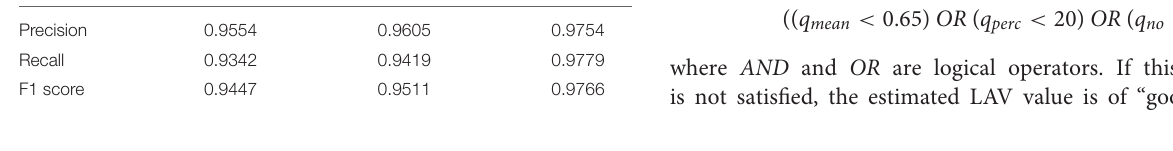
TABLE 9 | Confusion matrices for the classification models using the evaluation dataset ( N = 3,172) with class 0 (absence of LA in an image) and class 1 (presence of LA in an image). Model